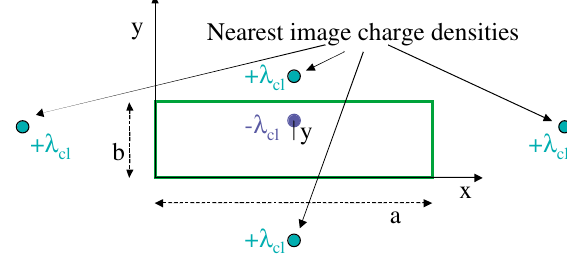
FIG. 4. (Color) A cartoon showing a tilted beam and the electric field on the tail of the beam due to cloud compression on the axis. The beam is moving up.